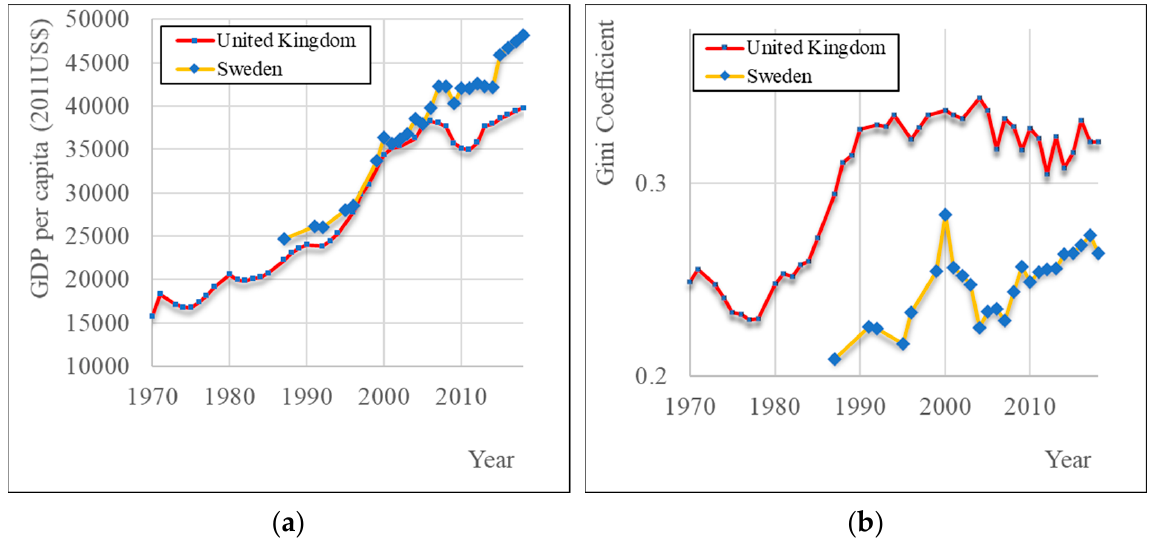
Figure 17. Sweden and United Kingdom, timeline of: ( a ) Gini coefficient; ( b ) GDP per capita.